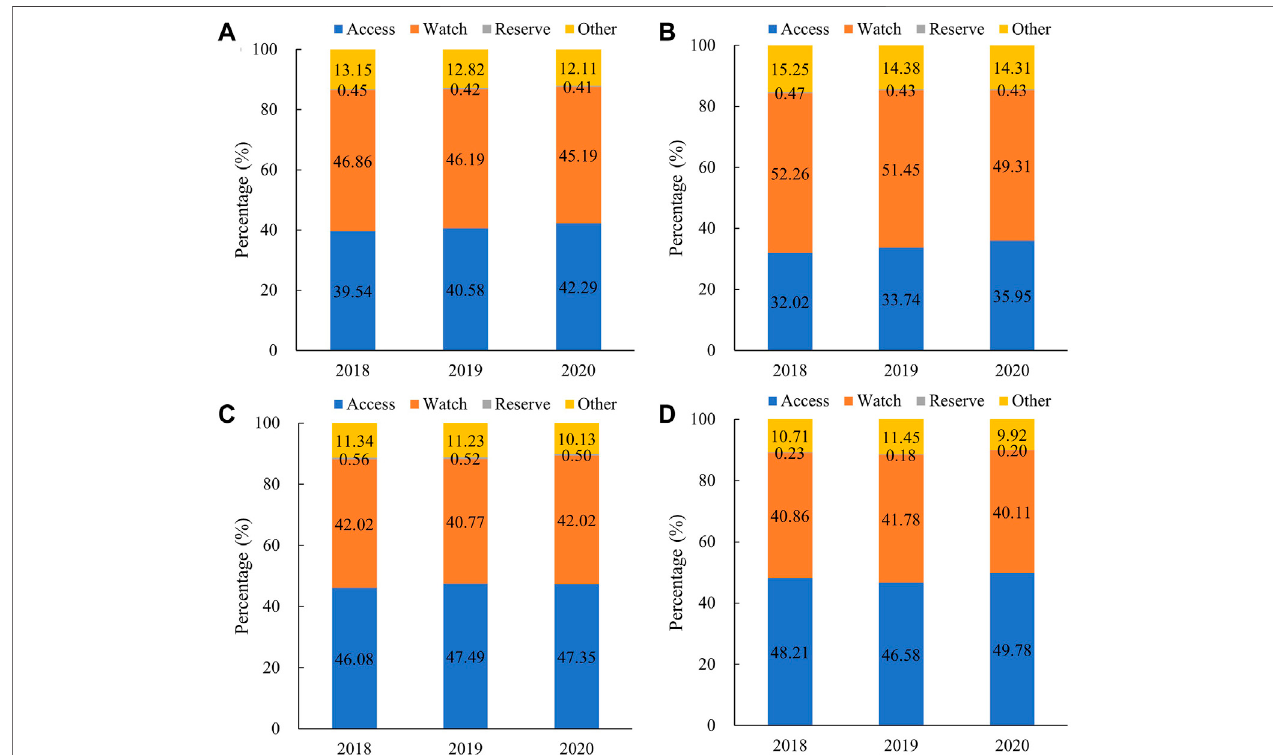
FIGURE 2| Proportional consumption (%) of antibiotics used in medicalinstitutions byAWaRe categorization in China, 2018 – 2020. (A) Overall, (B) eastern China, (C) central China, and (D) western China. Note: Data of 24 provinces were involved.